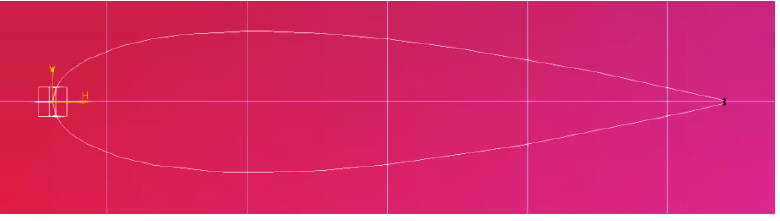
Figure 4. Sketch of the Darrieus rotor blade in CATIA.